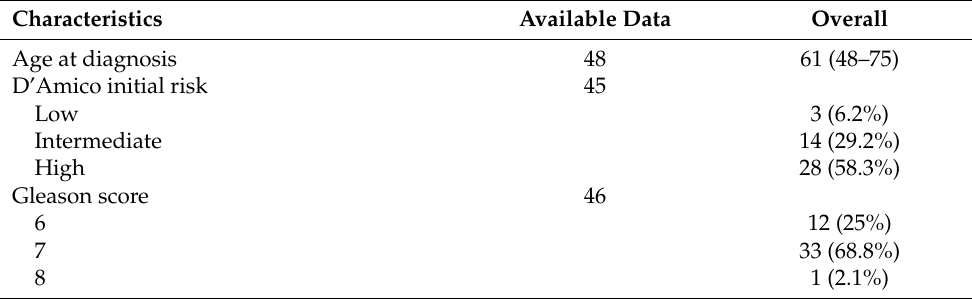
Table 1. Patient initial